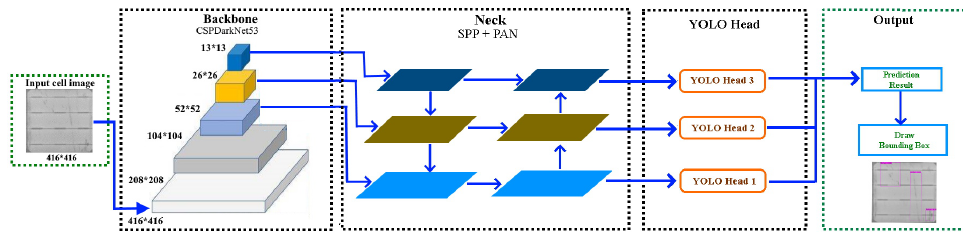
Figure 6. The architecture of